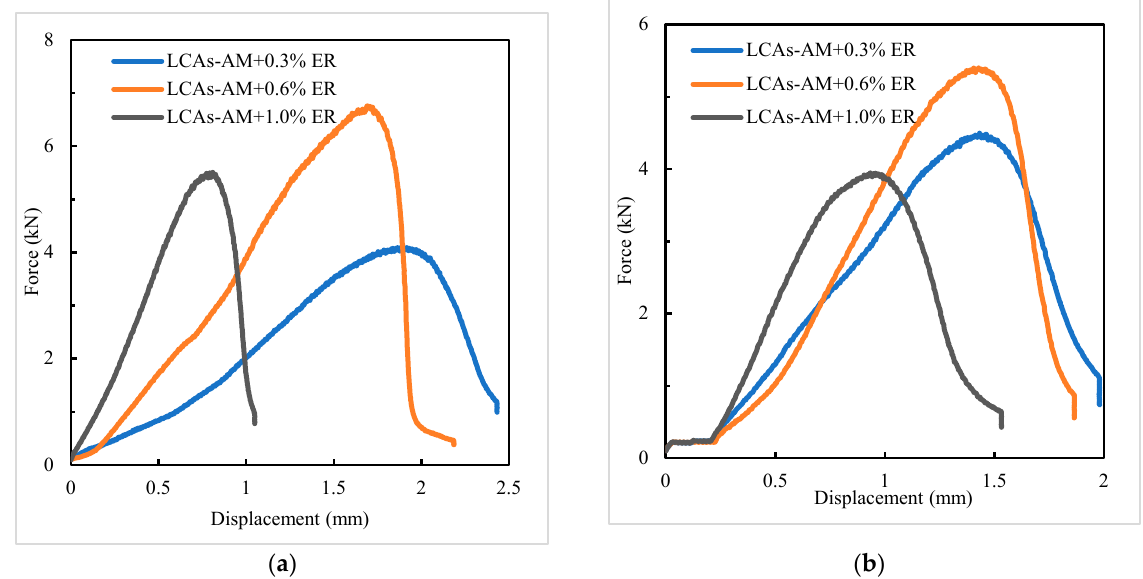
Figure 9. Displacement and load curve of SCB tests: ( a ) − 10 °C; ( b ) 0 °C. Table 11. SCB test results of LCA-AMs.